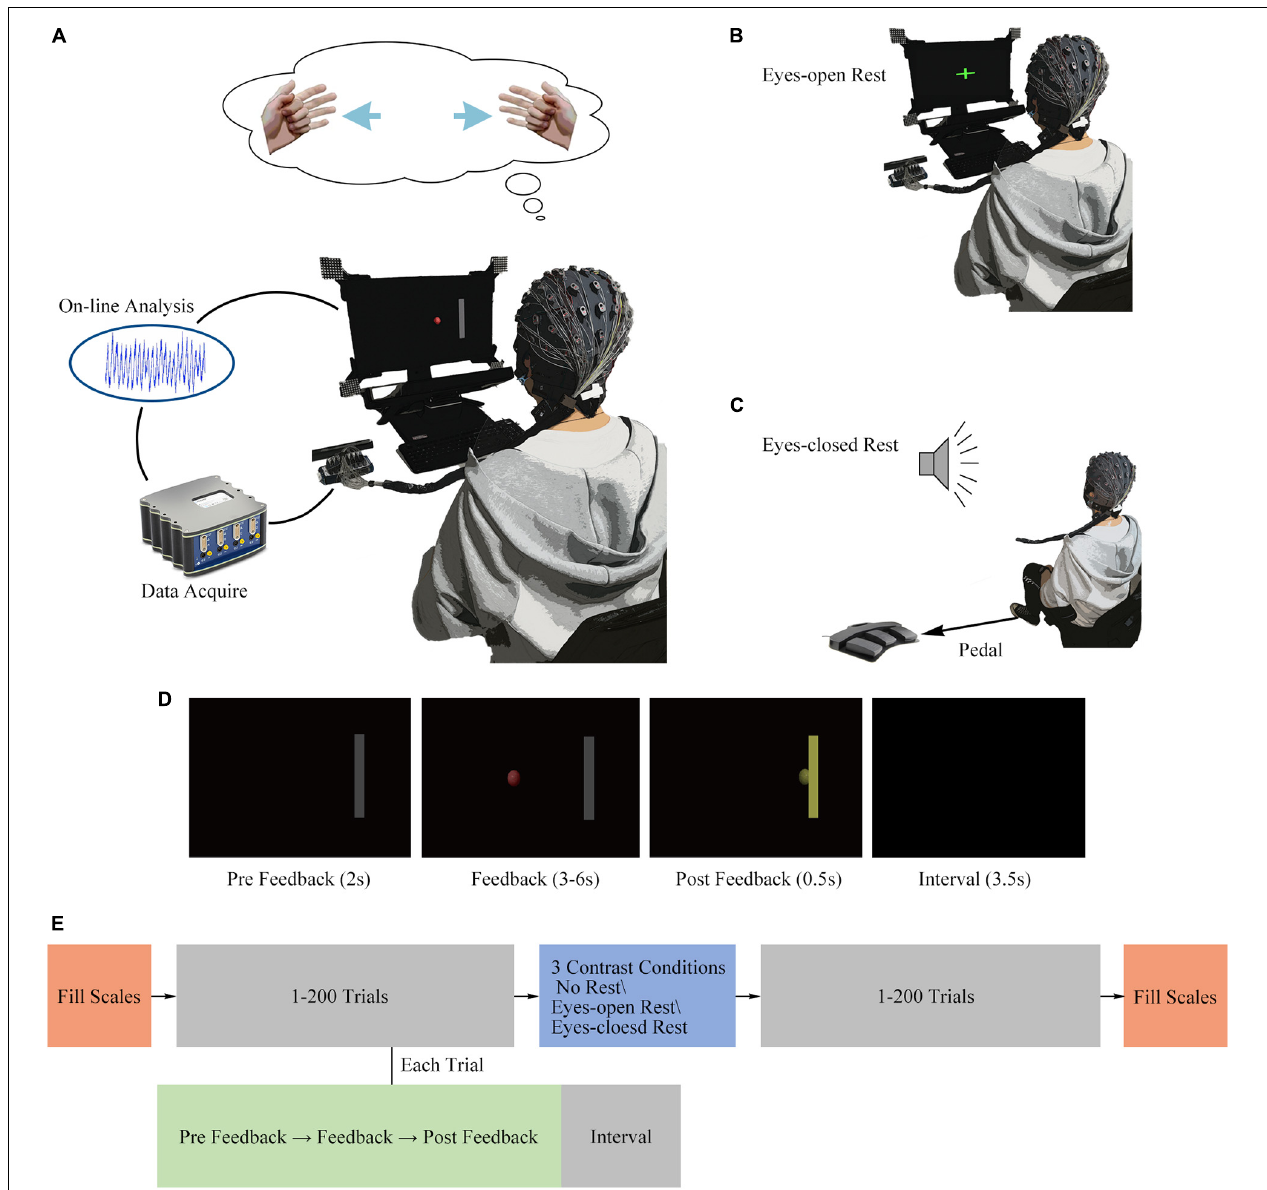
FIGURE 1 | Experimental design. (A) Illustration of a subject controlling a cursor by imagining the movement of hands. (B) Illustration of a subject staring on the green cross in the center of the screen in the eyes-open rest condition. (C) Illustration of a subject stepping on the pedal according to an audio stimulus in the eyes-closed rest condition. (D) Screenshots of four different stages in a single trial. (E) Illustration of a session and a trial